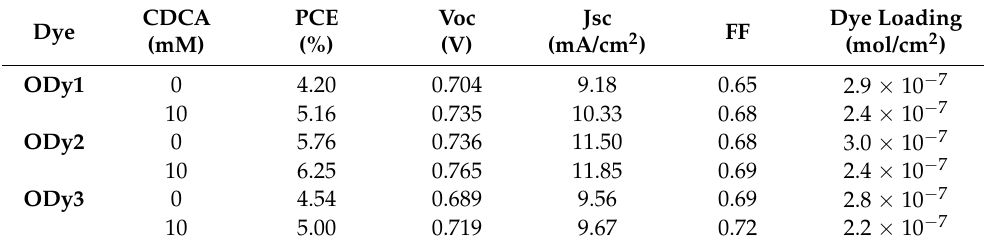
Table 3. Photovoltaic parameters for DSSCs based on ODy1, ODy2 and ODy3